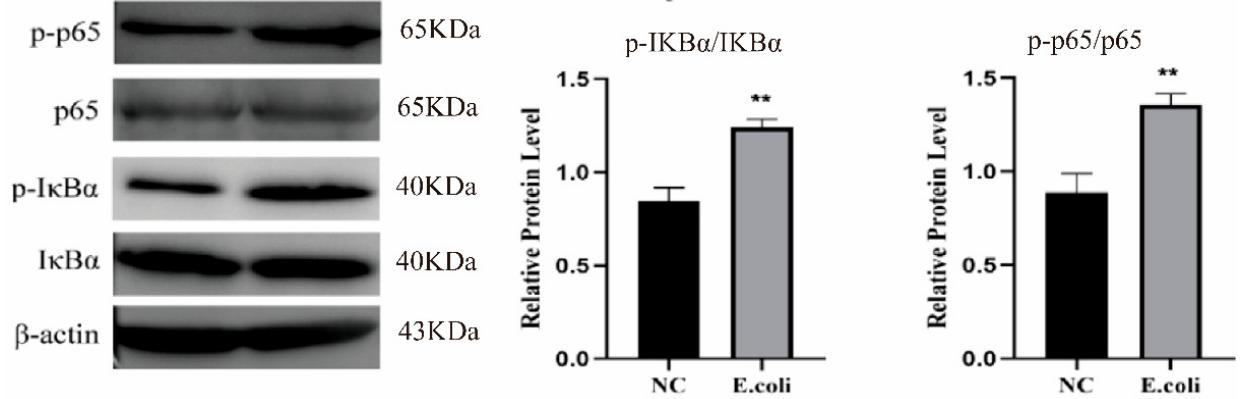
Figure 2. Effects of Escherichia coli on NF- κ B. **, p < 0.01, indicating a significant difference compared with the NC group.